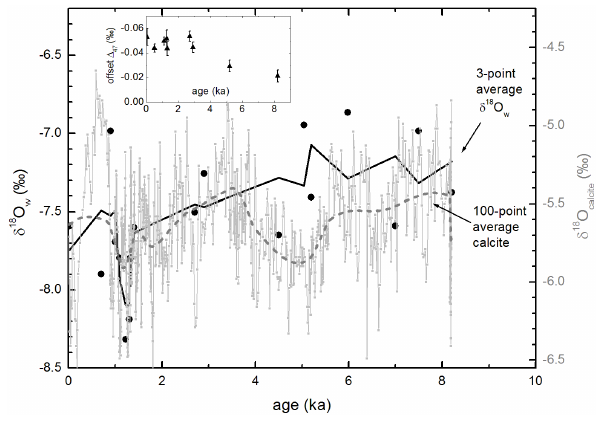
Fig. 5. Reconstructed drip-water δ 18 O w values based on the co- variation method (black circles, left axis) for stalagmites BU1 and BU4. The thick black line is a moving three-point average of the δ 18 O w values. The typical uncertainty of a single data point is 0.3‰. Calcite δ 18 O c values (grey, right axis) of stalagmite BU4 (adapted from Fohlmeister et al., 2012) and its 100-point moving average (dashed grey line) are given for comparison. The differ- ences between both curves are attributed to changes in both tem- perature and kinetic isotope fractionation (given in the inset as the measured 1 47 offsets of stalagmite BU4, adapted from Kluge and Affek, 2012).